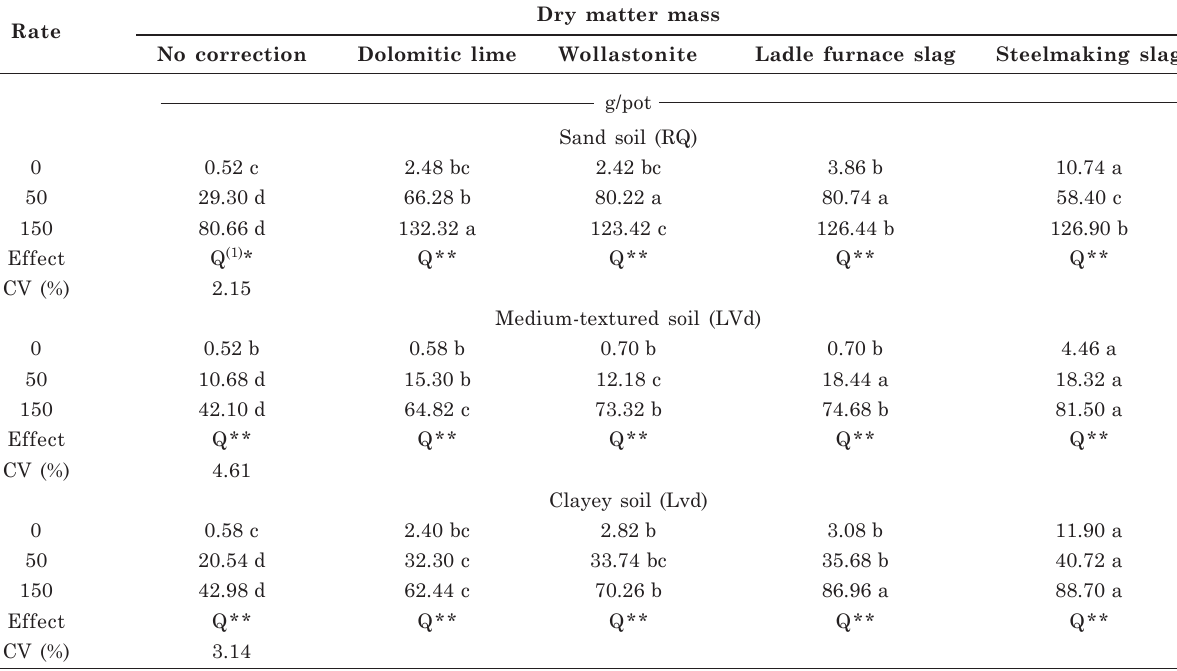
Table 6. Dry matter mass of corn plants according to corrective application and P rates in